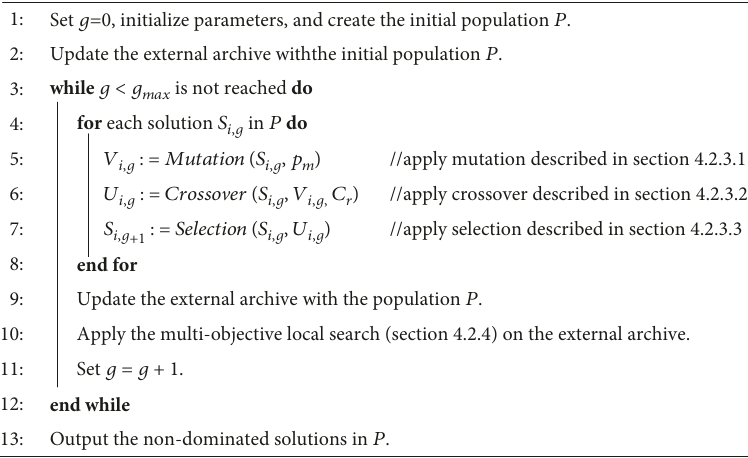
Figure 8: Procedure of the discrete multiobjective di ff erential evolution